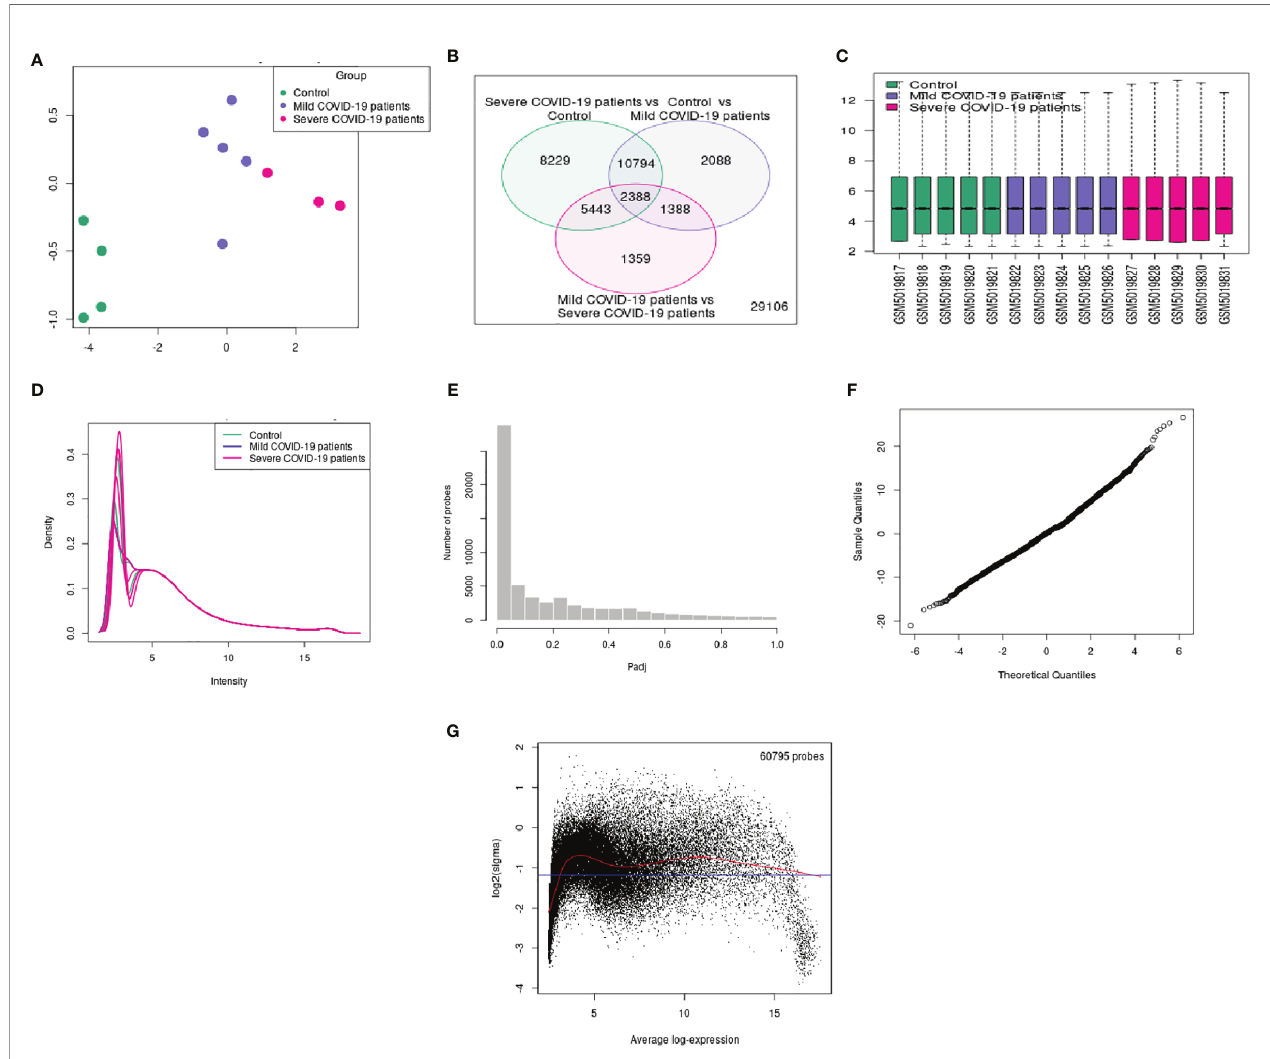
FIGURE 4 | Different types of statistical plots were developed from our study. (A) UMAP plot visualizing samples related to each other. (B) Venn diagram shows the groups ’ common genes. (C) The box plot shows the distribution of the selected samples ’ values for this study. (D) The expression density plot shows the distribution of values of the DEGs of the three groups. (E) The adjusted p-value histogram represents the p-value in the experiment (the top DEGs). (F) The moderated t-statistic q-q plot shows our DEGs data sample against the theoretical quantiles a Student ’ s t distribution. (G) The mean-variance trend plot shows the mean-variance relationship of the gene expression